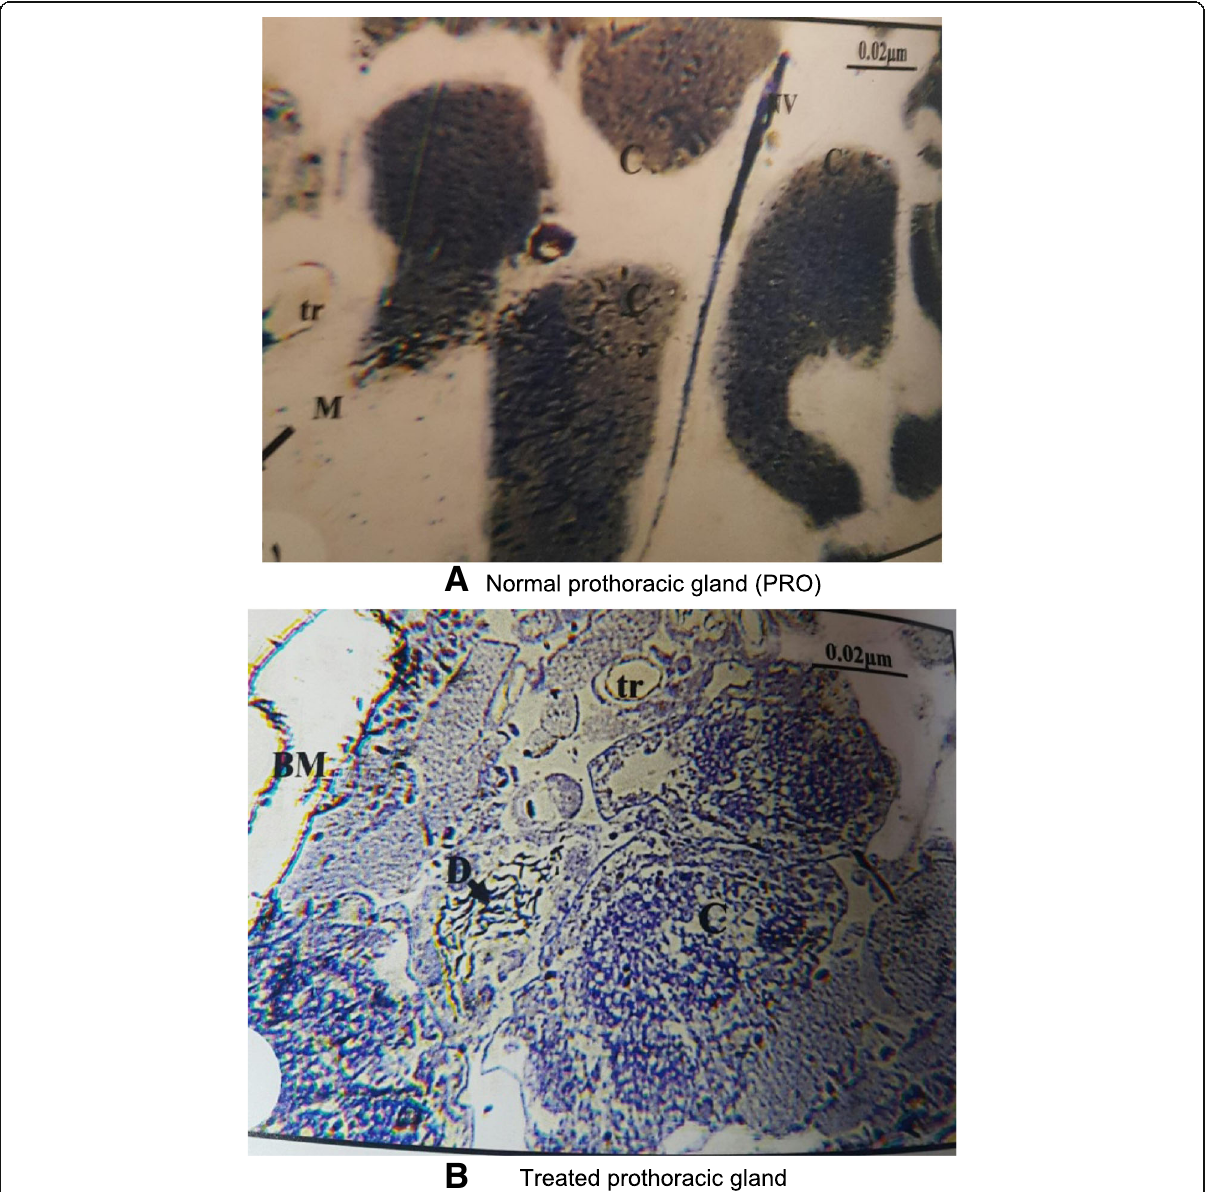
Fig. 5 a Normal prothoracic gland (PRO). b Treated prothoracic gland. Semi thin sections by light microscope in different parts in the endocrine organs in larvae of the potato tuber moth Phthorimeae operculella ( a normal and b treated larvae). Abbreviations: NSC neurosecretory cells in medial cerebral, NV nerve, CC corpora cardiac, NC nerve cells, NL neural lamella, D dendrites, HS droplets of secretion, SG salivary gland, HSD hormone secretion droplets, NM neuropile mass, CA corpus allatum, AO aorta, Tr tracheoles, Pg prothoracic gland, C cell body, M membrane, BM basal